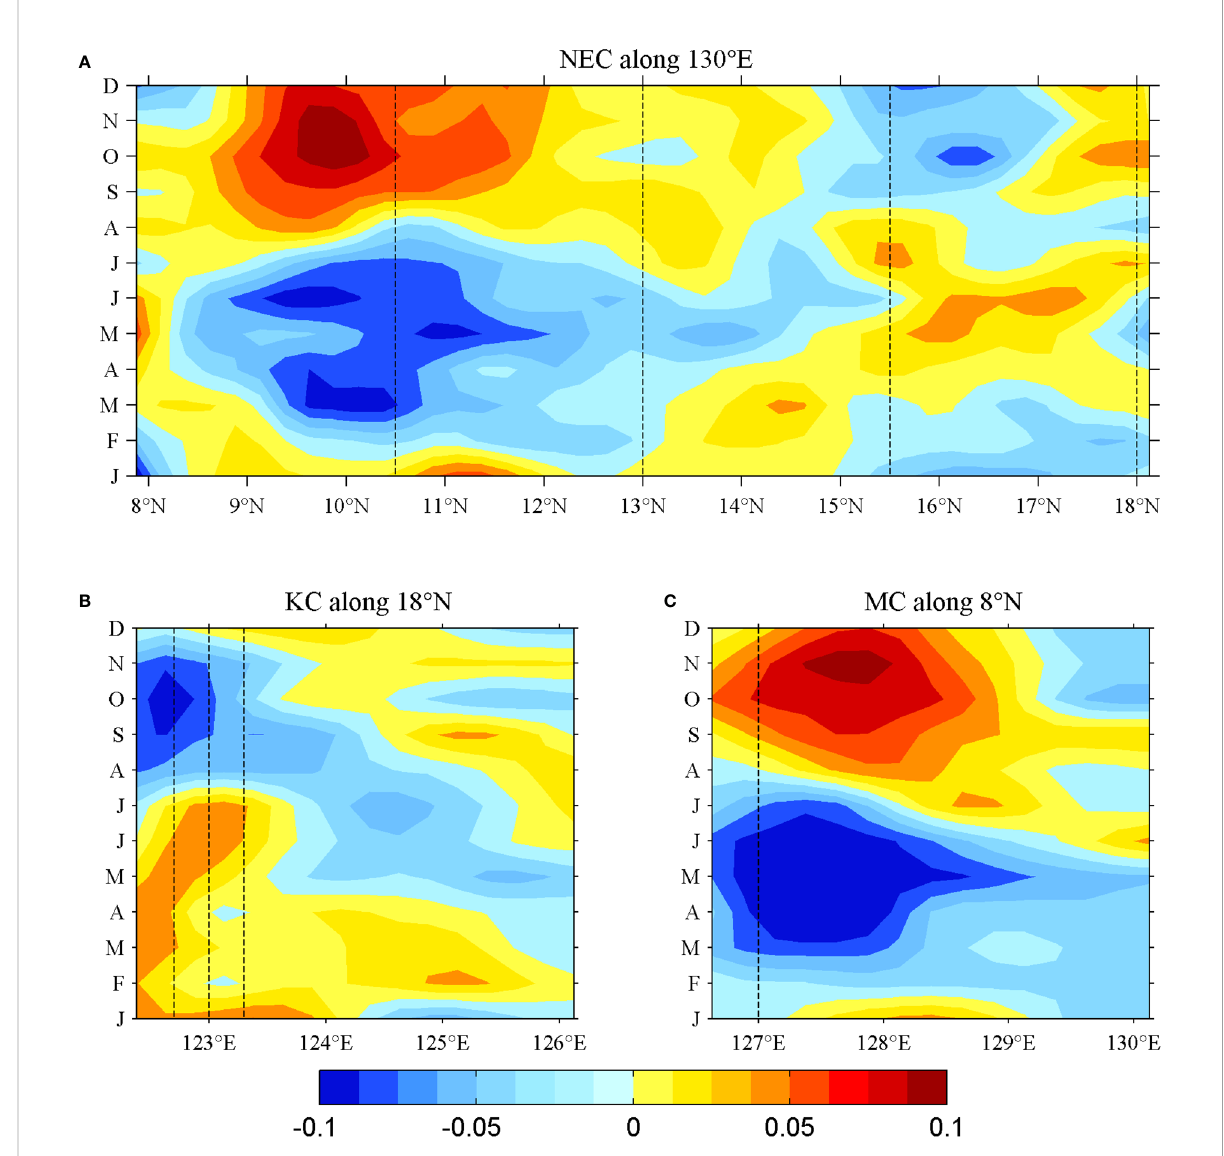
FIGURE 6 (A) Mean monthly zonal velocity anomalies from satellite data along 130°E and mean monthly meridional velocity anomalies from satellite data (1993 – 2019) along (B) 18°N and (C) 8°N. (Units are m/s.) The dotted lines represent the location of moorings. Note that the directions of the NEC and MC are opposite to that of the